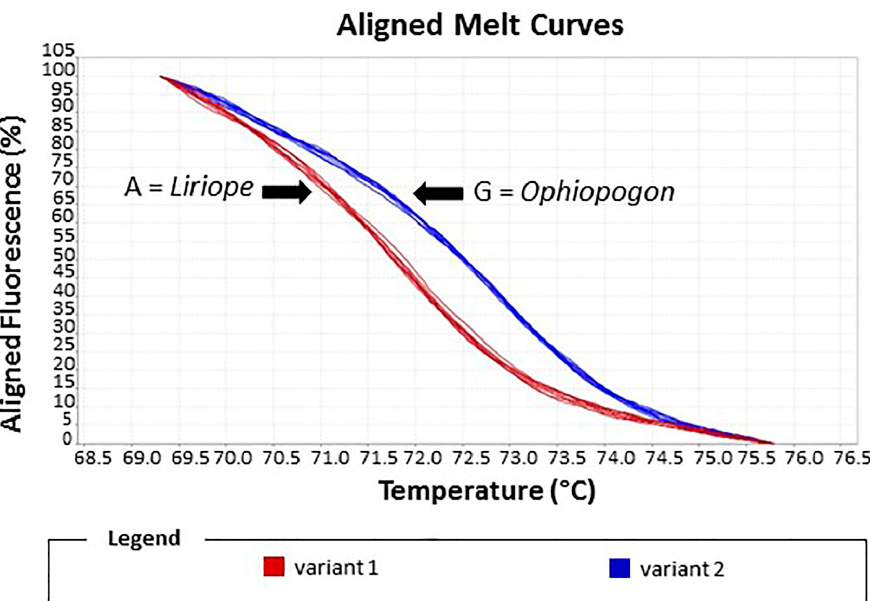
Figure 7. HRM assay of reference standards and test samples. The melting curve plot showed two distinct variants: Variant 1, Liriope standards; Variant 2, Ophiopogon standards. Test samples were assigned to the Liriope or Ophiopogon genus according to which variant curve they matched.